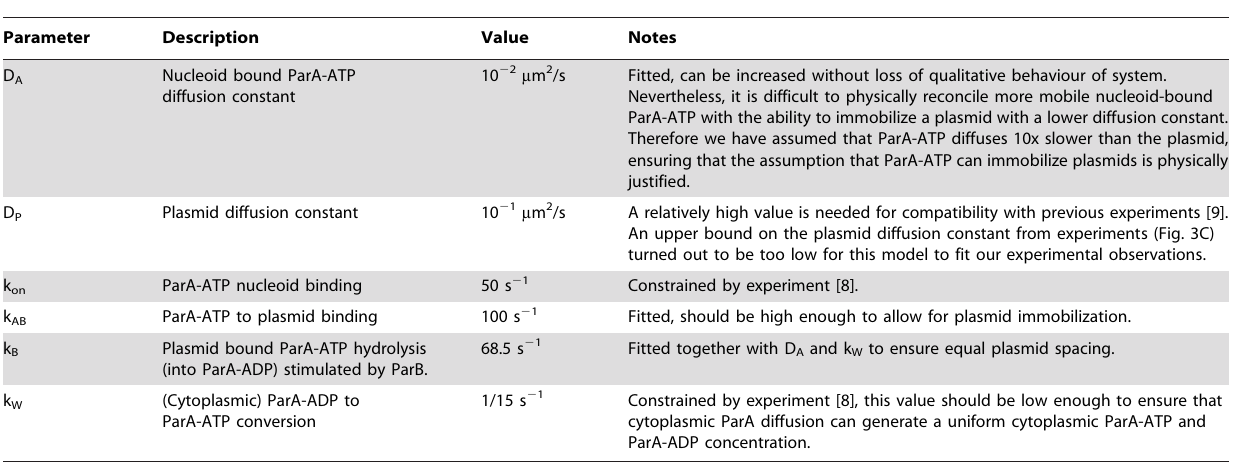
Table 2. Parameter values used in the diffusion/immobilization